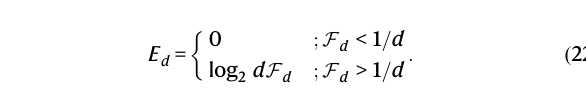
Figure 6 plots these sequential fi delities as a function of thinning ( n =log 2 T ) for all BFCs characterized in the main text. In all cases, we consider the full measurement sets, R = 21 for the PPLN results and R = 30 for the MRR fi ndings, as these cases generally possess the slowest MCMC convergence. As expected, the sequential fi delity converges more rapidly with T for lower d ; nonetheless, all examples > 0 : 99 at their respective maximum of n , ultimately reach F n , n (cid:2) 1 indicating high MCMC convergence for all reported ρ B matrices.